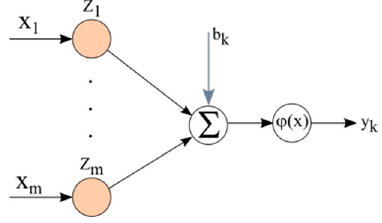
Figure 8. Graphic example of fully connected layers function.